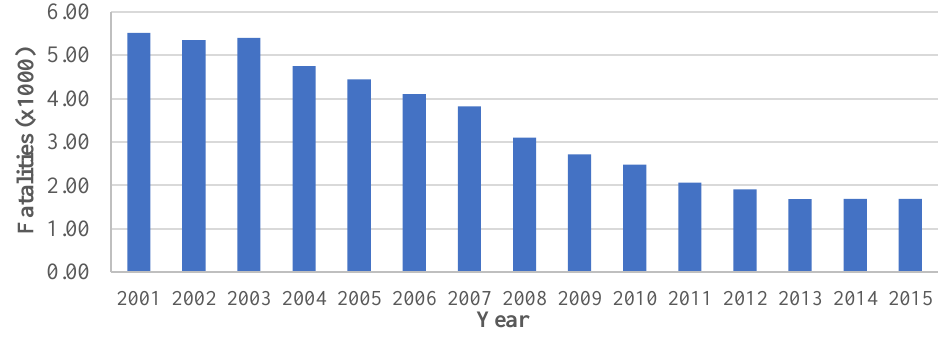
Figure 1. The number of fatalities in Spain between 2001 and 2015 and the EU target reduction (29%) between the end of 2010 and 2015 [6].